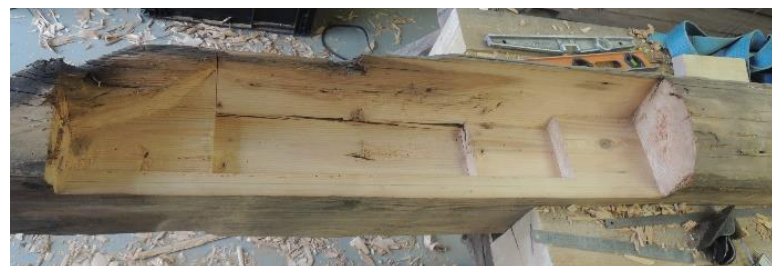
Figure 27. Finally cleaned part of the damaged beam.